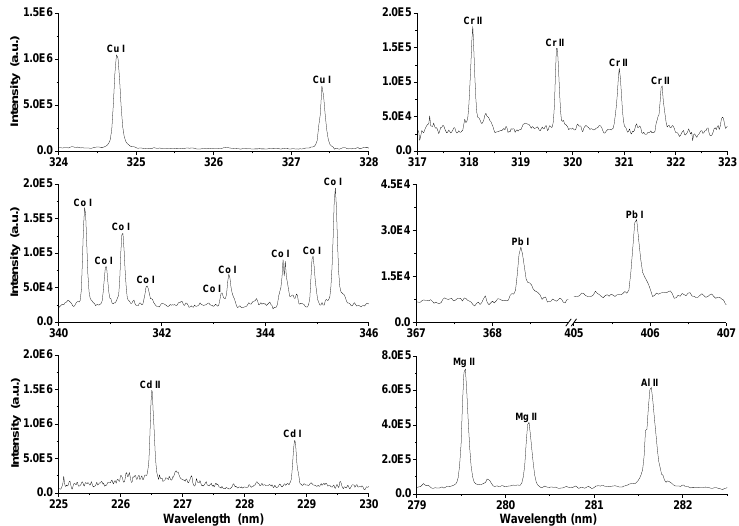
Figure 2. Spectral lines of elements (copper, chromium, cobalt, magnesium, aluminum, cadmium, and lead) identified in the laser-induced breakdown spectroscopy (LIBS) spectra of zeolite.